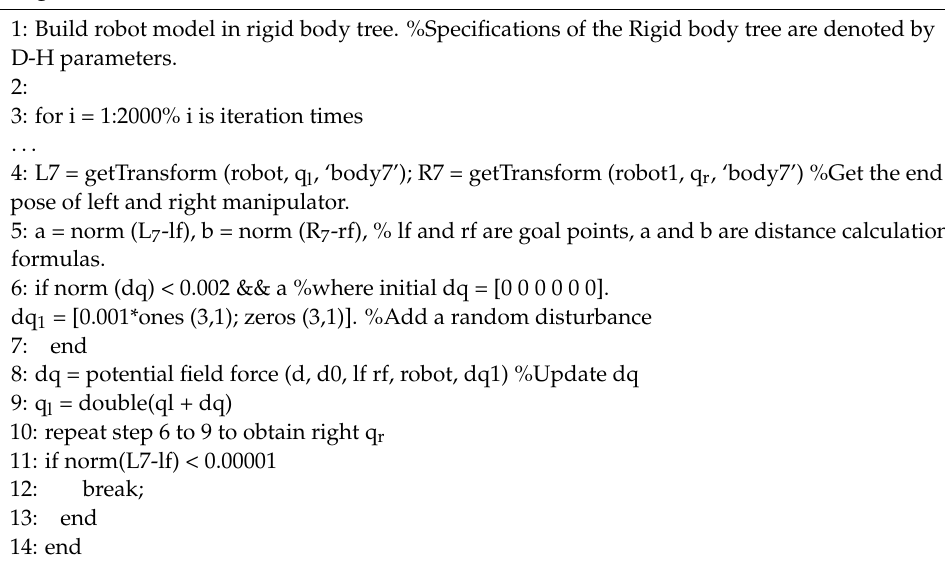
Algorithm 1. Calculate distance between links.